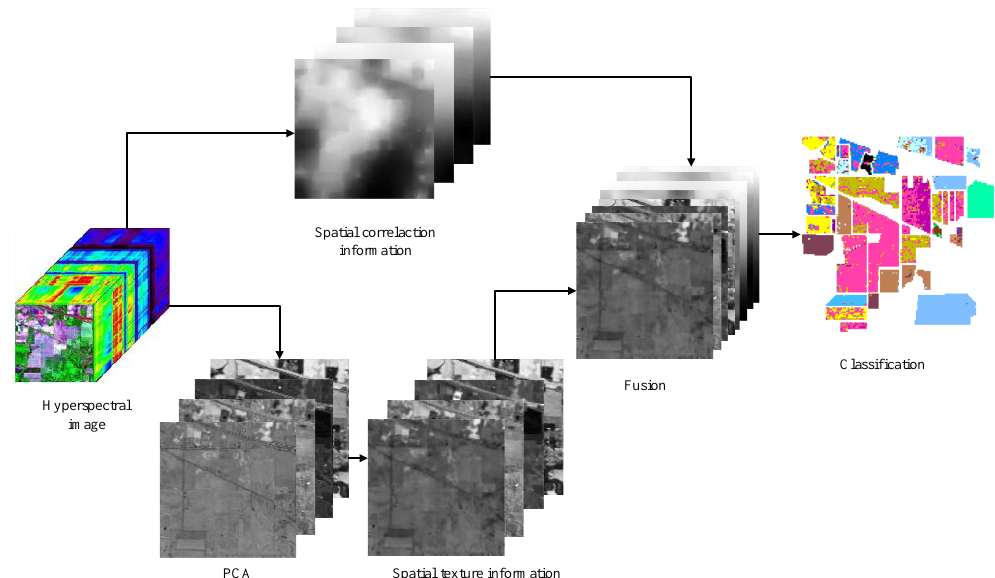
Figure 5. Flow of the proposed curvature filter domain transform recursive filter (CFDTRF-LDM).